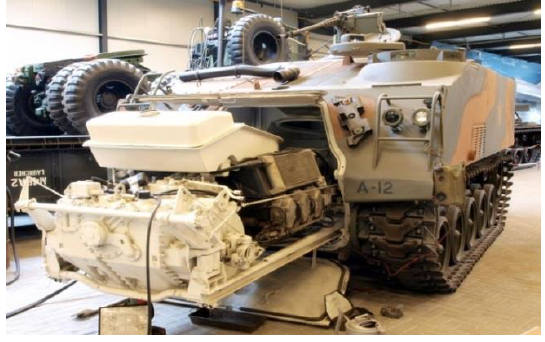
Fig. 5. Removal of the Powerpack system from the M75 APC infantry transport vehicle [11]